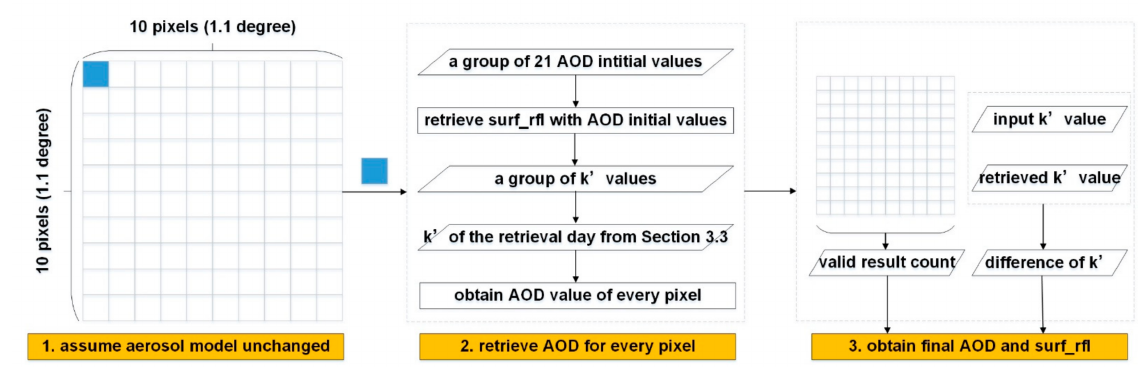
Figure 10. Flowchart of the dual-channel AOD retrieval algorithm after the determination of the surface reflectance ratio k (cid:48)